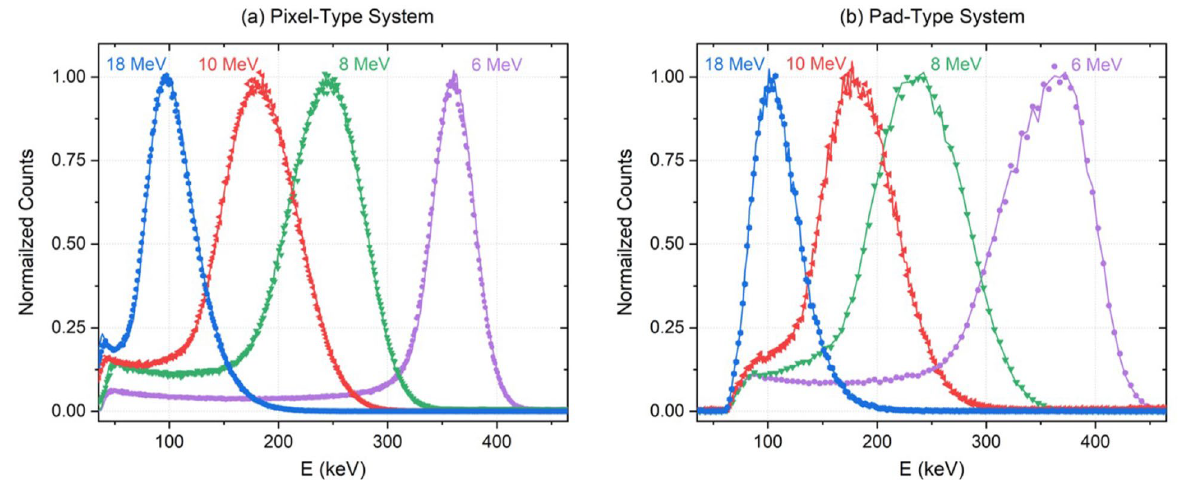
Figure 5. Experimental energy spectra obtained under proton irradiation at four different energies for both systems using the calibration per chip (solid lines) and the calibration per channel (points).